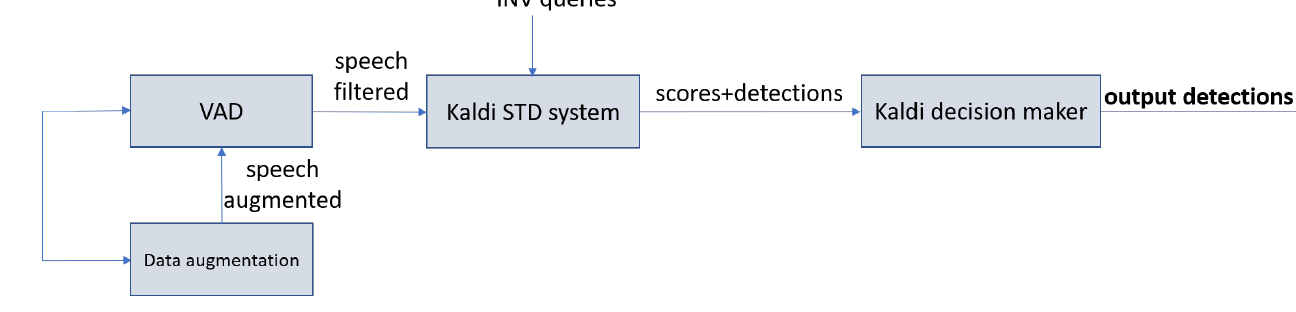
Figure 1. Architecture of the Kaldi DNN + DA